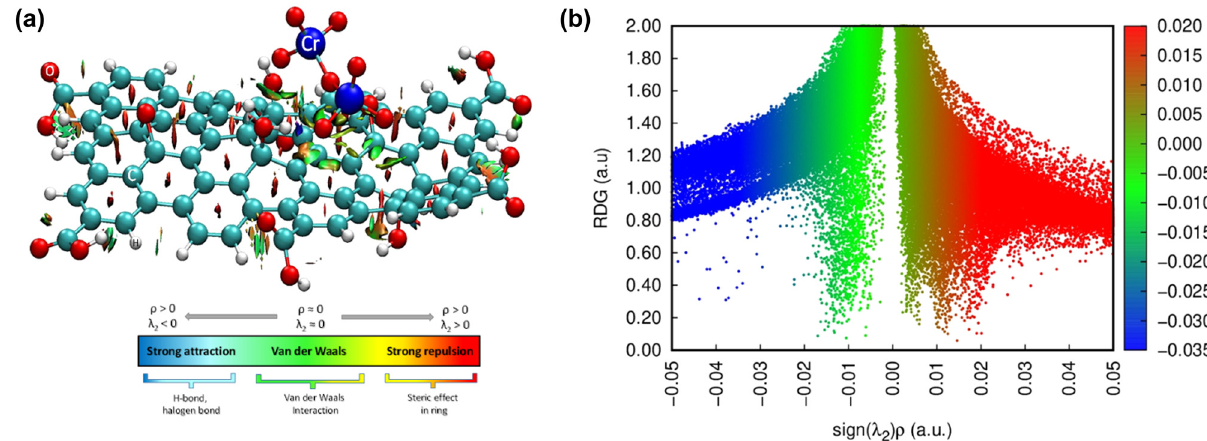
Figure 4: ( a ) Noncovalent interaction surfaces and ( b ) the plot of RDG vs sign ( λ ) ρ for the interaction of GO/dichromate ion ( Pose_3 )